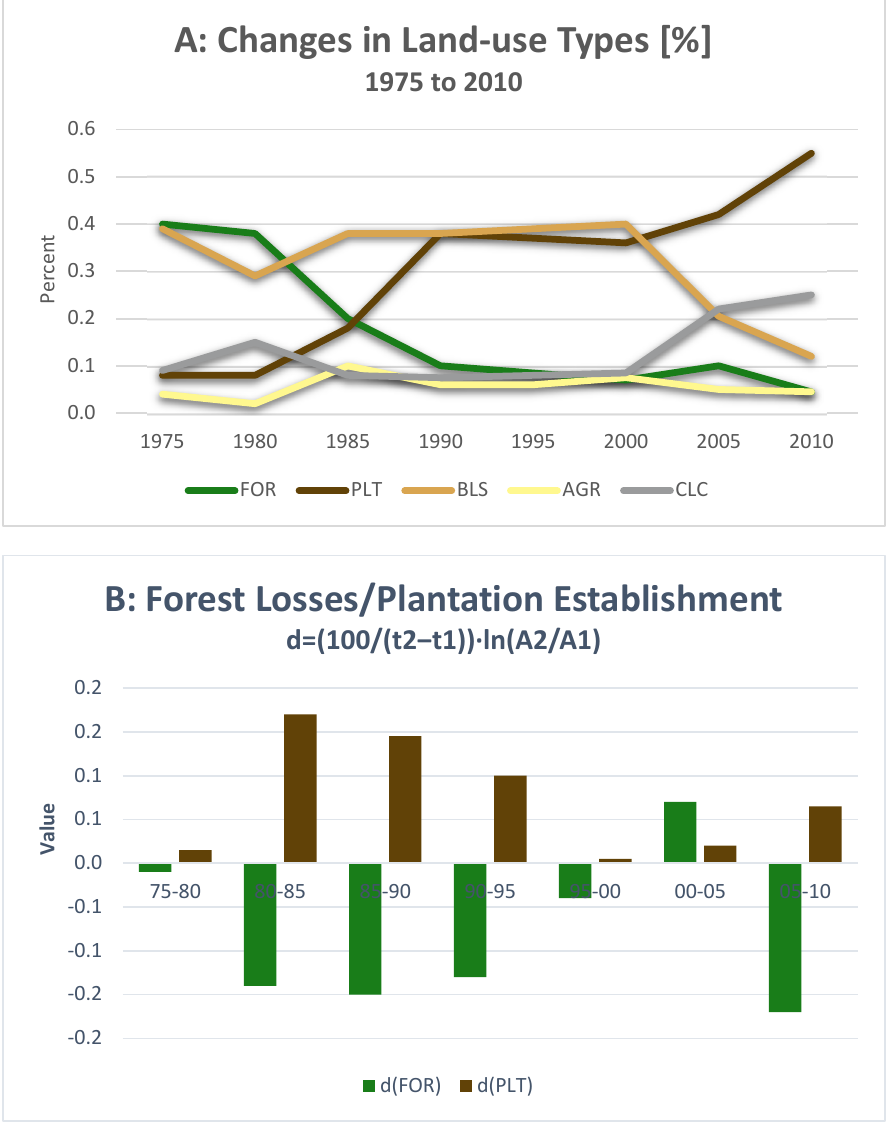
Figure 4. ( A ) Percentages of main land use types (forest, plantation, bushlands, agriculture, clearcut) in five-year intervals, ( B ) Rates of deforestation of native forest and afforestation with industrial plantations in five-year intervals.